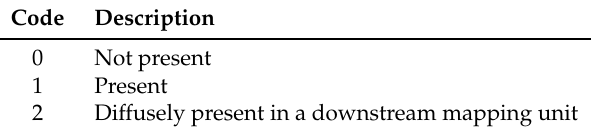
Table A4. Artificial connection.